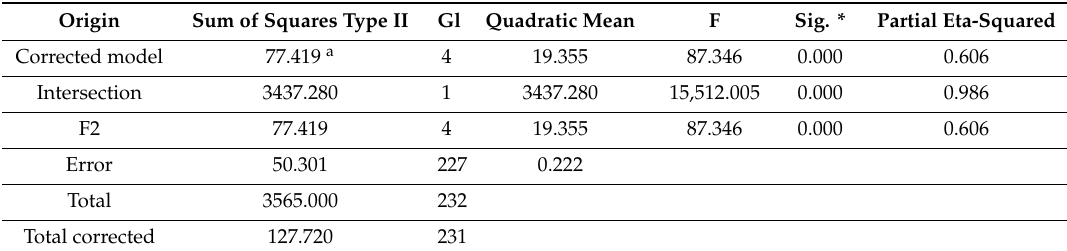
Table 6. Tests of the inter-subject e ff ects between F1 and F2.